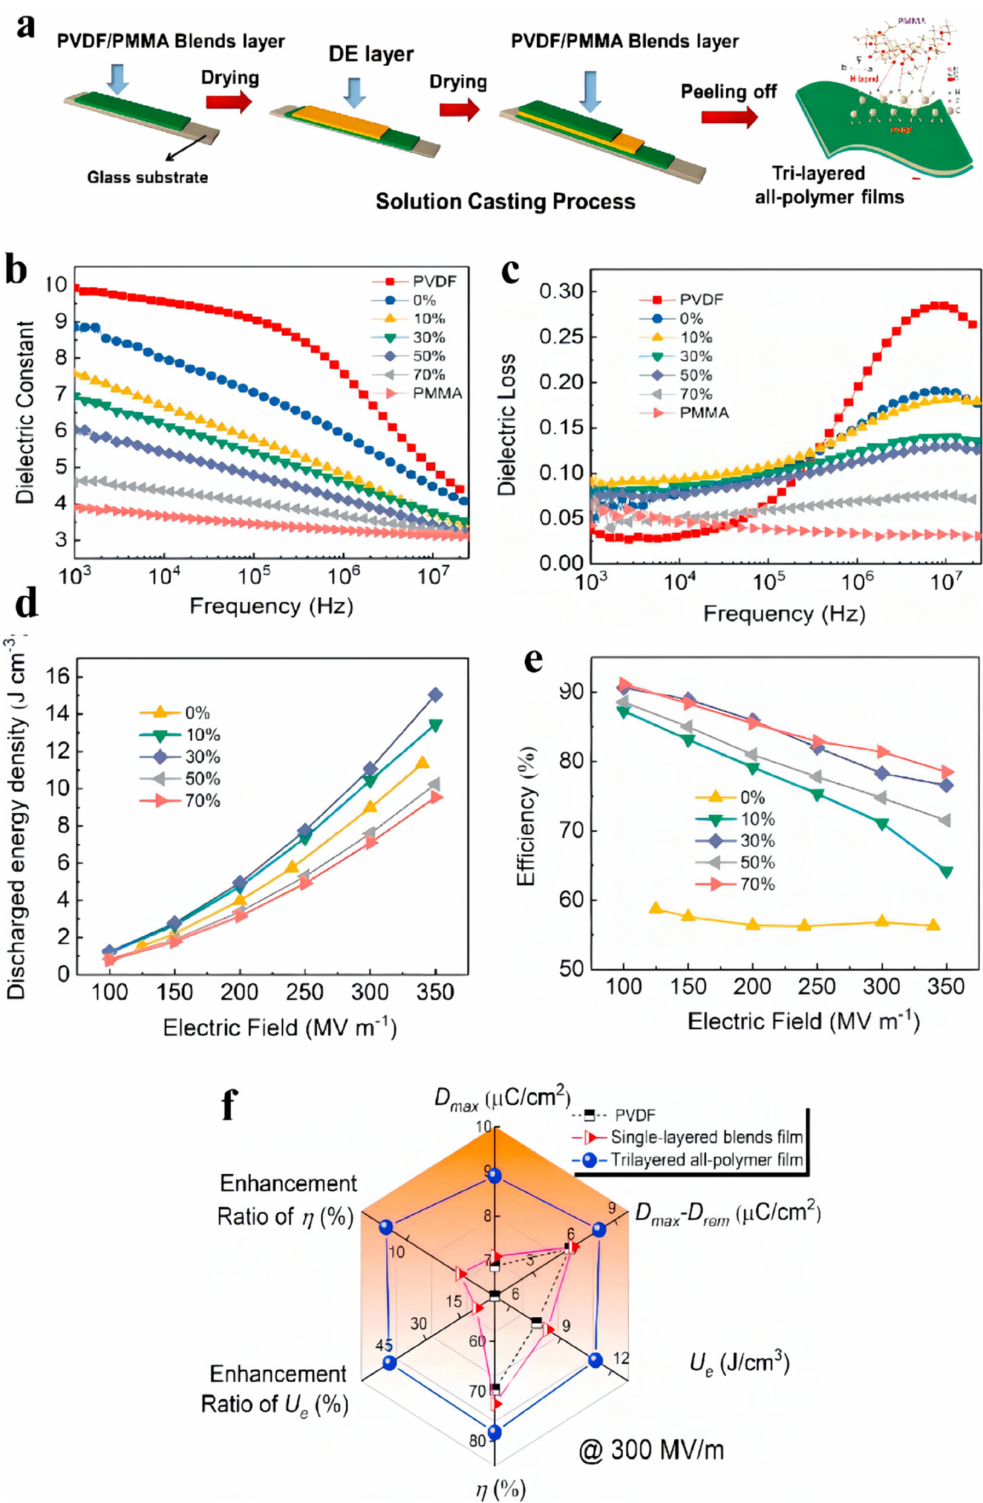
Figure 7. ( a ) Preparation diagram of the solution-processed solution casting process. ( b ) Frequency- dependent dielectric constant. ( c ) Dielectric loss. ( d ) Energy density under varied electric fields. ( e ) Efficiency under varied electric fields. ( f ) Comparison of D max , D max – D rem , U e , η , the enhancement ratio of U e and η among pristine PVDF, single-layered blends’ film, and tri-layered all-polymer film. Adapted with permission from [39], Copyright © 2022